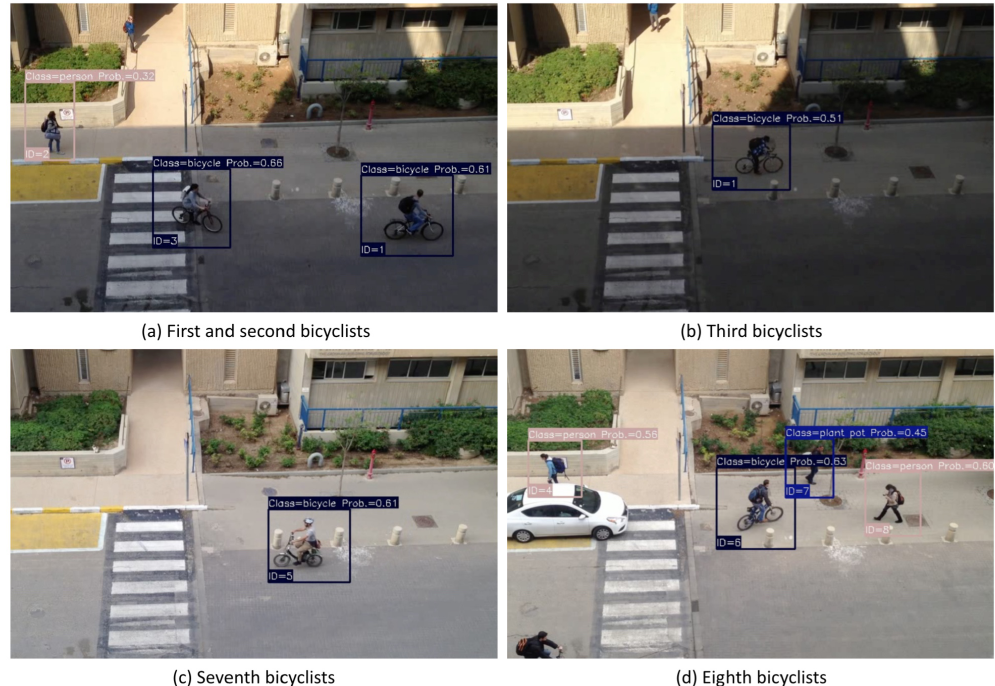
Figure 13. Classification results of the bottom-up pathway (Faster Region-based Convolutional Neural Network (FRCNN) with ZF model) for bicyclists passing through the test scene. Examining the confidence level of the system for the ( a ) first and second bicyclists, ( b ) the third bicyclist, ( c ) the seventh bicyclist, and ( d ) the eight bicyclist shows constant performance. In addition, one of the people in (d) is misclassified as a plant due to the vegetation behind him.